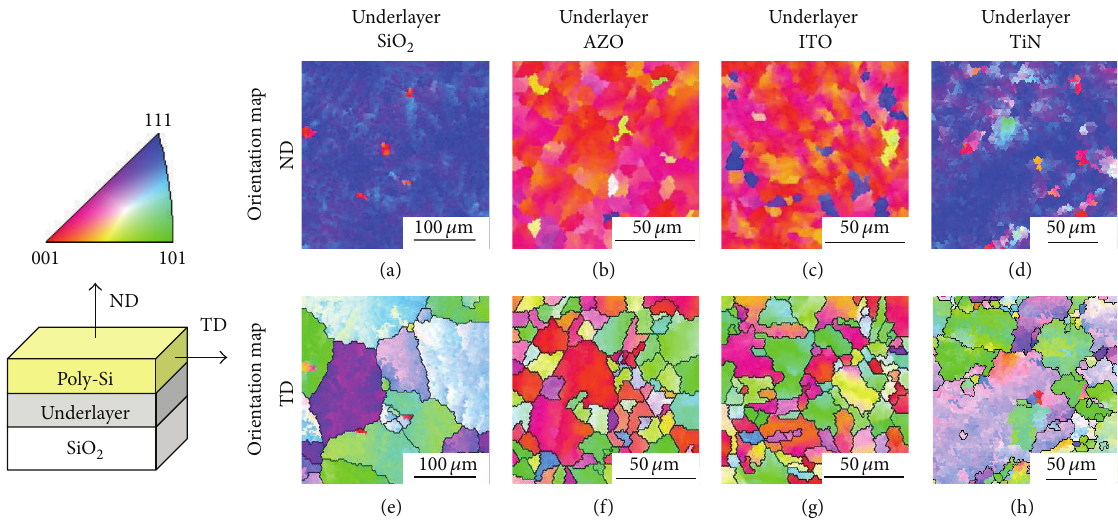
Figure 3: EBSD images of the poly-Si layers with SiO 2 , AZO, ITO, and TiN underlayers. (a)–(d) ND and (e)–(h) TD relative to the substrate; the ND and TD maps are of the same regions for each sample. The colors indicate the crystal orientation, according to the inserted color key. The black solid lines in the TD maps indicate random grain